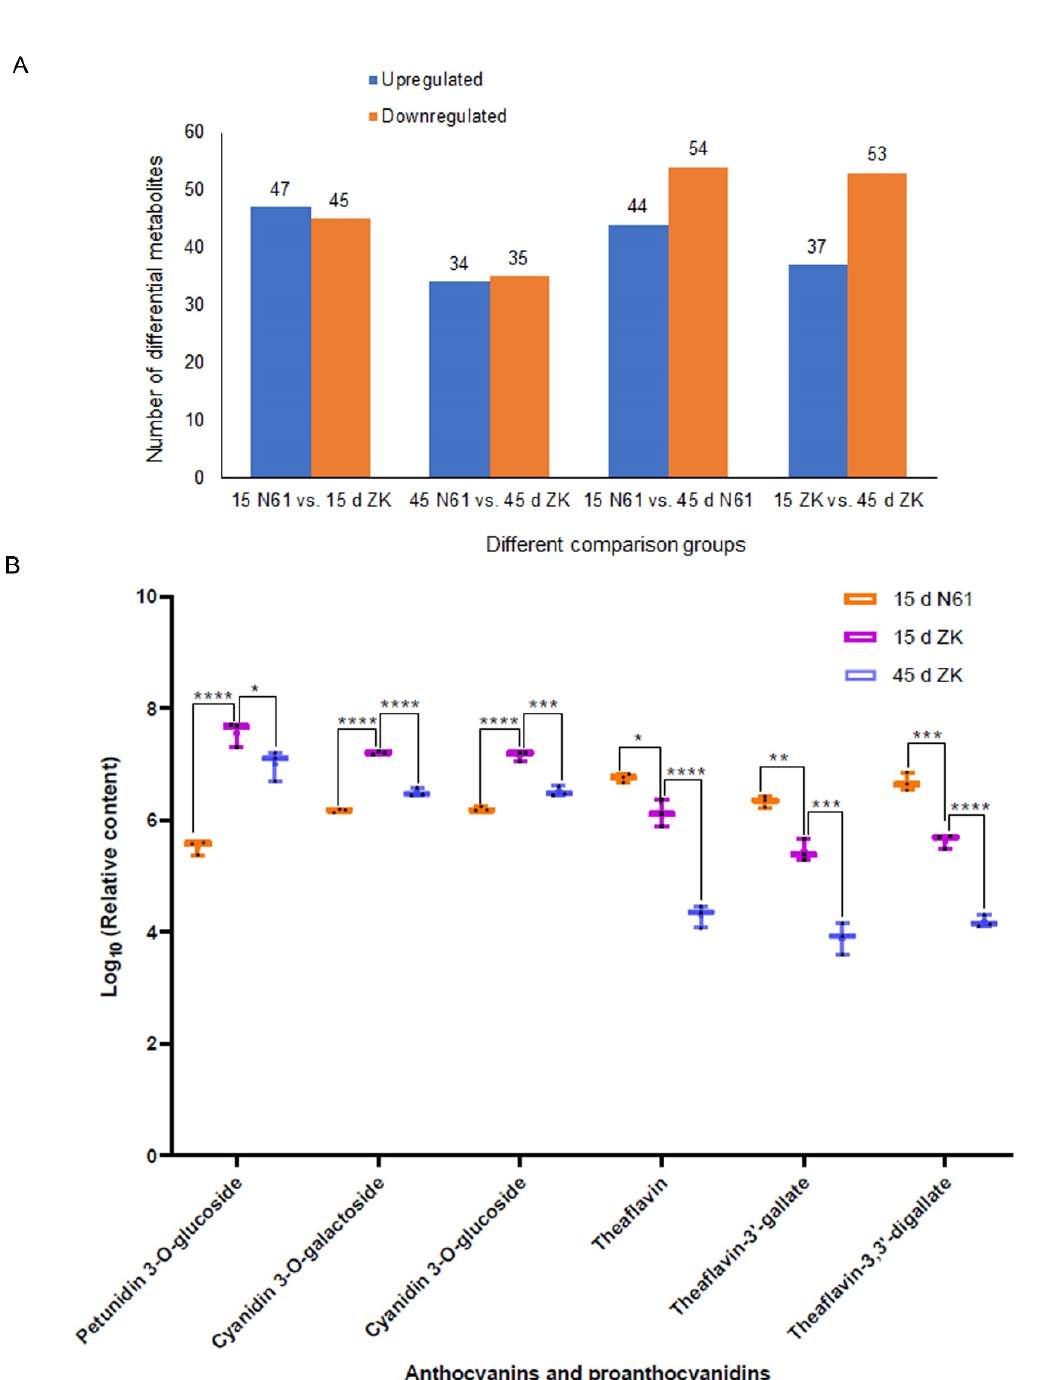
Figure 2. Analysis of differential metabolite components and relative content of key metabolites in the Zikui (ZK) and N61 cultivars. ( A ) Numbers of differential metabolites. ( B ) Relative content of key metabolites in ZK and N61 at 15 and 45 days, presented as dot whisker plots ( n = 3 independent biological samples; * p ≤ 0.05, ** p ≤ 0.01, *** p ≤ 0.001, **** p ≤ 0.0001).